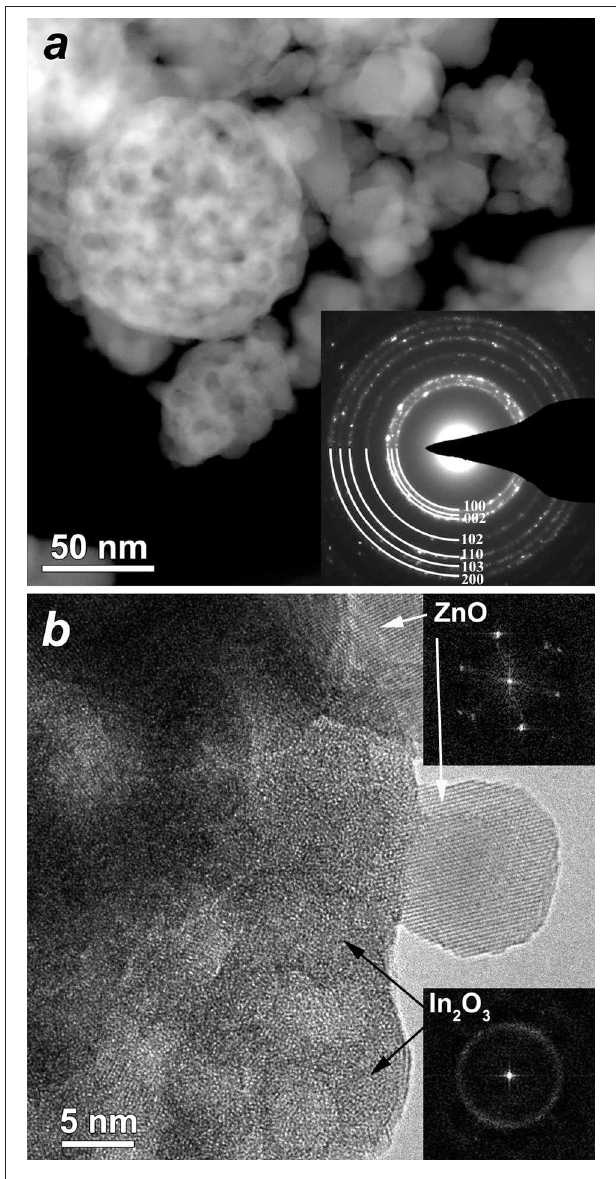
FIGURE 3 | (a) HAADF-STEM image of the ZnO(In, 5 at.%) sample; inset–ring electron diffraction pattern acquired from the large area. The rings are completely indexed using wurtzite structure, (i.e., from center to periphery) 010; 002; 011; 012; − 120; 013; − 122. (b) HRTEM image of the ZnO(In, 5 at.%) sample showing individual crystalline ZnO particle and amorphous In 2 O 3 (corresponding FFT’s are inserted).